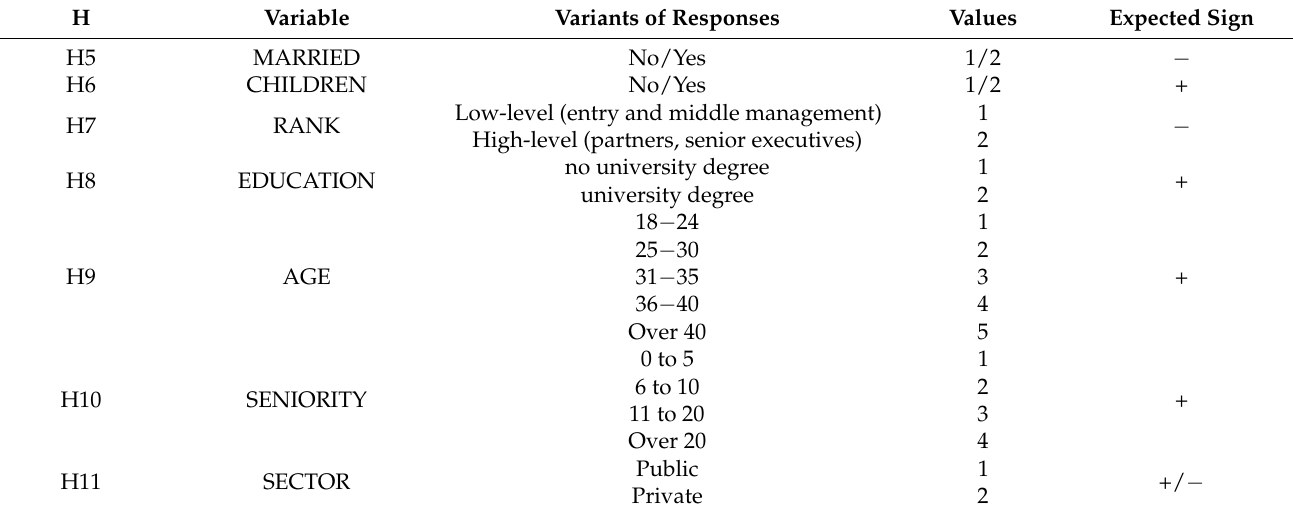
Table 2. Individual